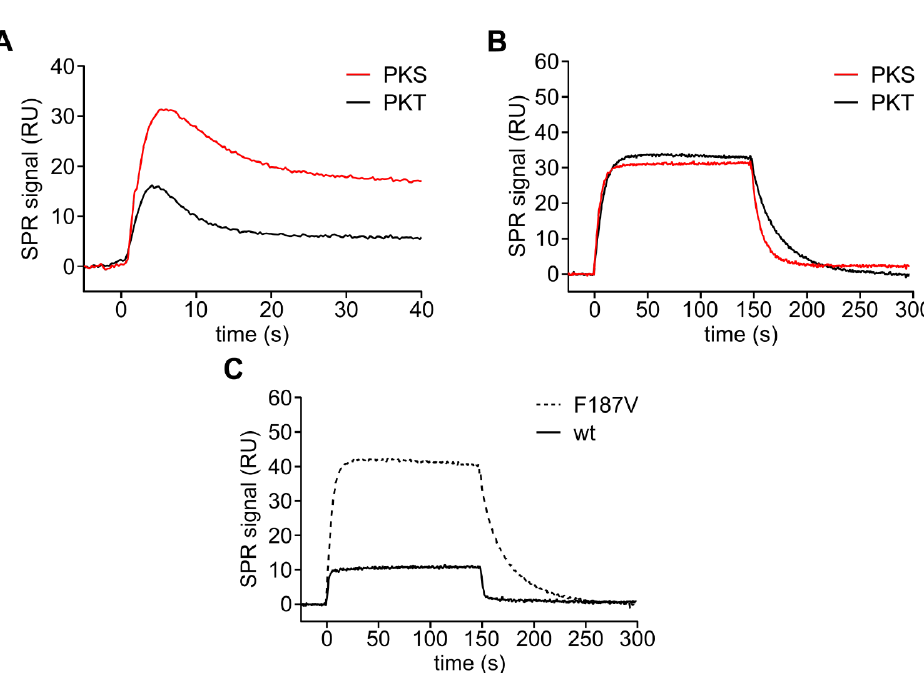
Figure 4. PKA Cα F187V has a higher affinity for the threonine substrate PKT. ( A ) On-chip phosphorylation of GST-PKS (red) and GST-PKT (black) with 100 nM PKA Cα F187V (Figure S9B,C). PKA Cα F187V phosphorylates GST-PKT faster than GST-PKS. ( B ) SPR analyses of the interaction between 50 nM PKA Cα F187V and GST-PKS (red) and GST-PKT (black), respectively, in the presence of 0.2 mM AMP-PCP and 1 mM MnCl 2 (Figure S9D,E). The mutant shows a slightly slower dissociation for the threonine substrate PKT. ( C ) Comparison of the binding curves of PKA Cα wt (solid line) and F187V (dashed line; 100 nM each) demonstrates that the mutant has a higher affinity for the threonine substrate PKT as the wt. See Table 4 for the determined rate constants and K D values.